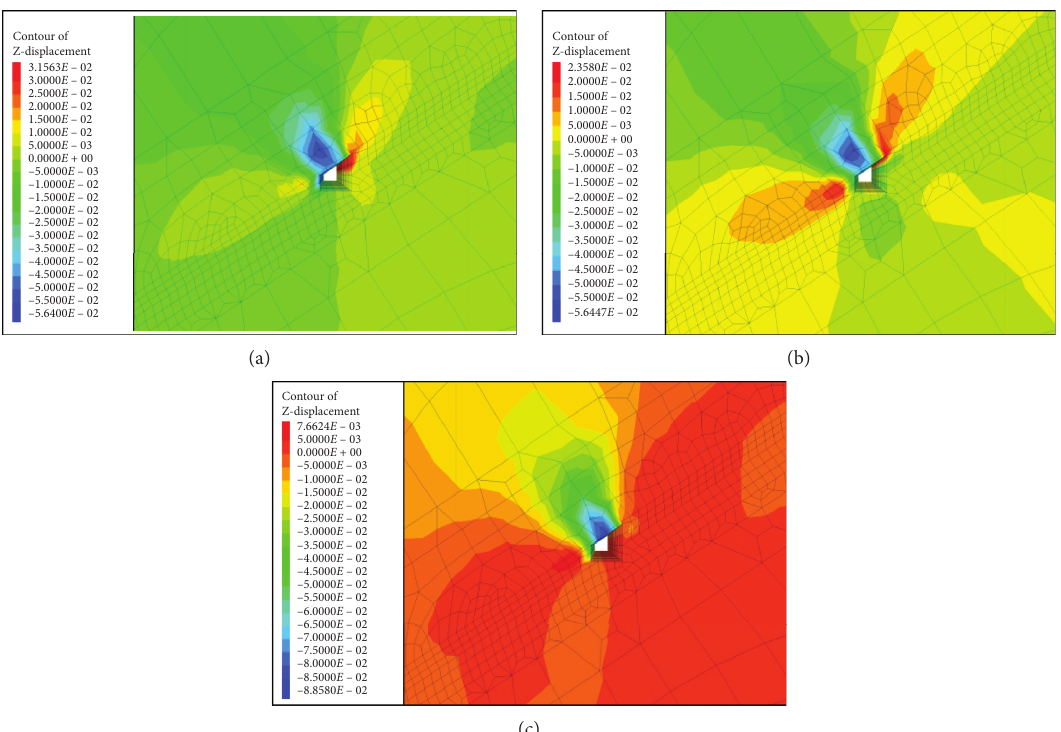
Figure 9: Displacement distribution. (a) Scheme 1: interval 1.0m × 0.8m. (b) Scheme 2: interval 1.0 m × 1.0m. (c) Scheme 3: interval 1.0m × 1.2m.